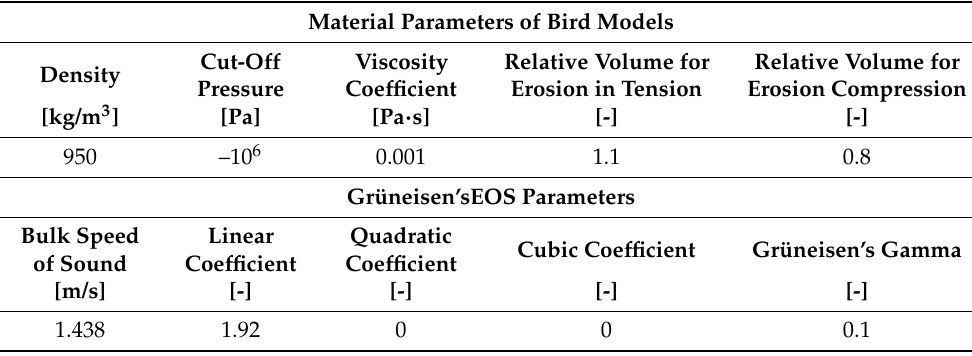
Table 1. Material and EOS data used in bird models [7].